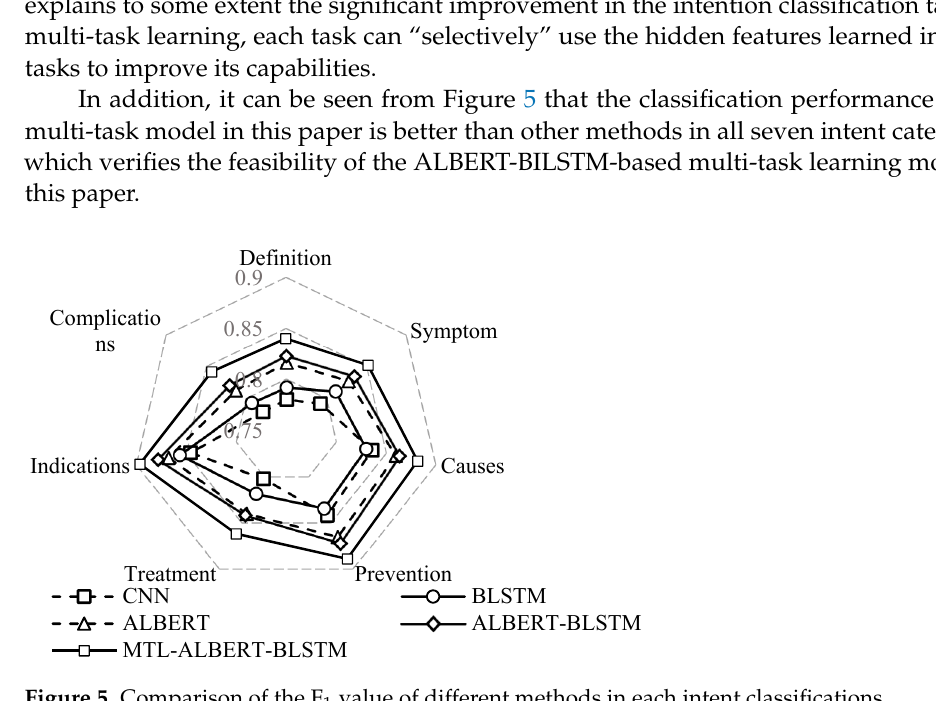
Figure 5. Comparison of the F 1 value of different methods in each intent classifications.